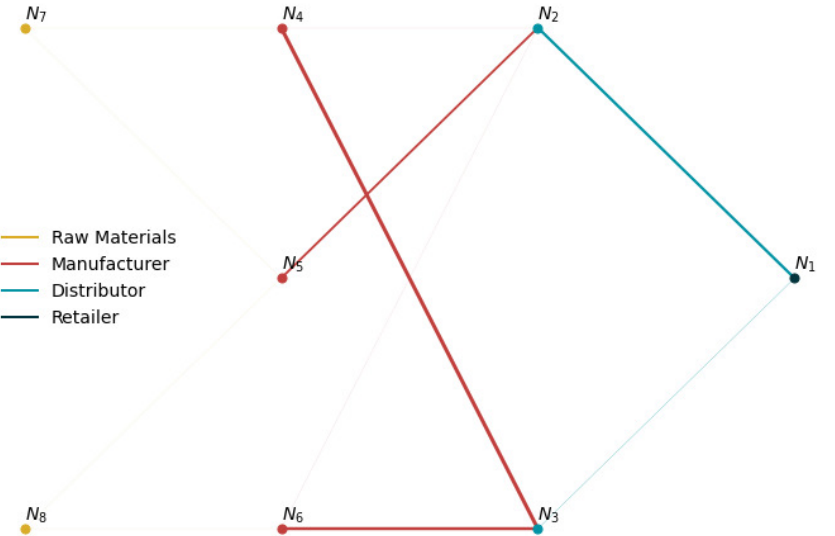
Figure 8. Average network flow with the MSSP-RH policy (lost sales mode). Total flow is proportional to the edge thickness.